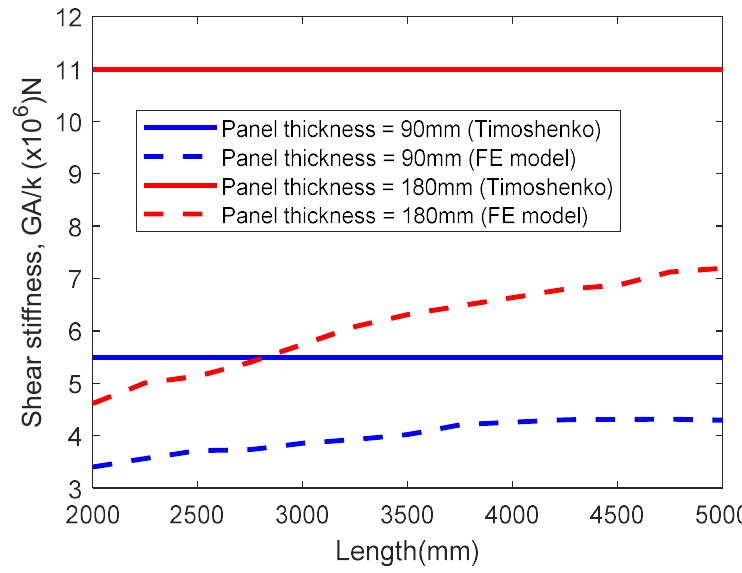
Figure 11. Variation of shear stiffness with changing length for panels of thickness 90 mm and 180 mm for cross-layer characterized by 250 MPa rolling shear modulus.